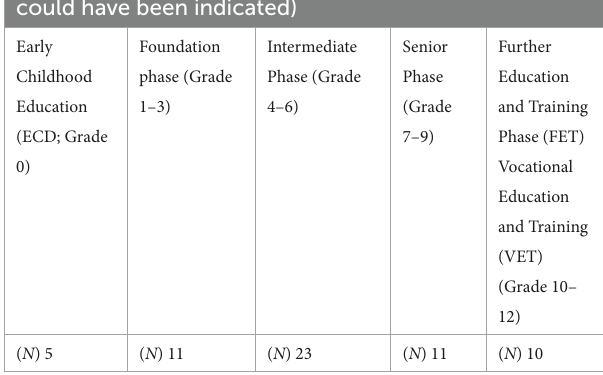
TABLE 2 Phase methodology taught by lecturers participants. Phase methodology were teaching two years prior, as well as during, the research study (more than one could have been